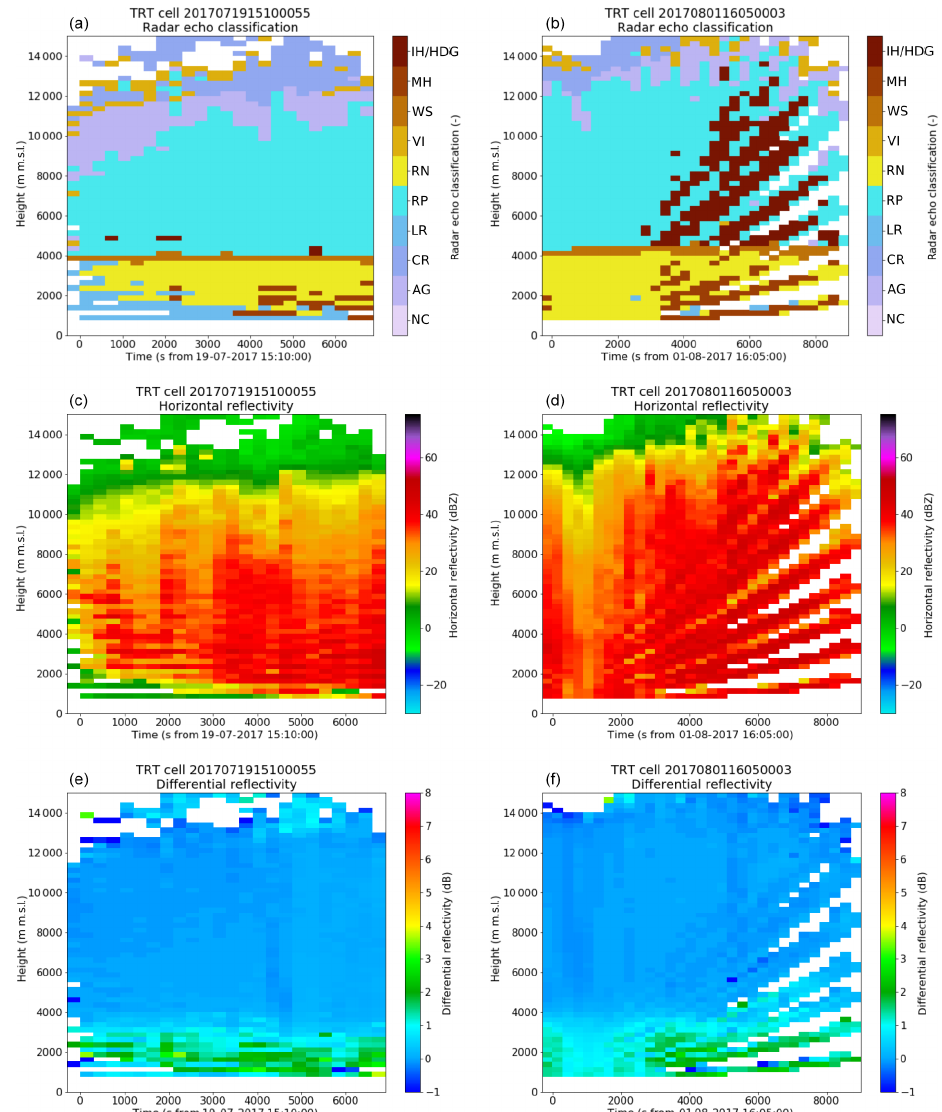
Figure 14. From (a) to (f) : profile of hydrometeor class (mode at each level), profile of reflectivity (median values at each height level) and profile of Z dr . (a, c, e) Cell 1; (b, d, f) cell